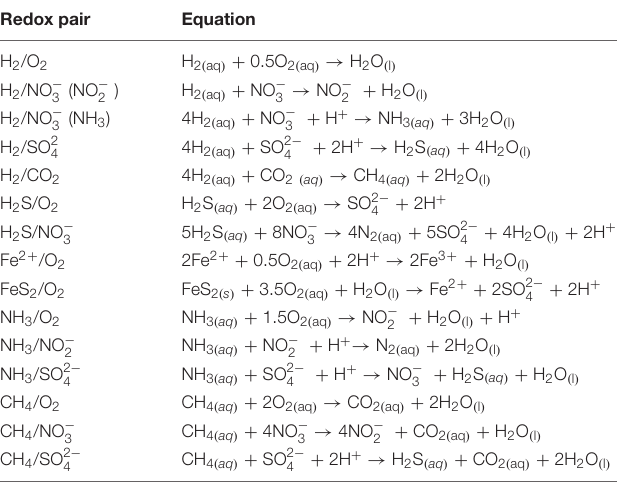
Environmental concentrations (listed in Supplementary Table S1 ) from references listed in Supplementary Table S2 . TABLE 2 | Reactions considered in Gibbs free energy and energy density